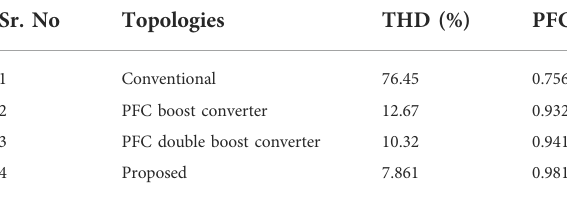
TABLE 2 Analysis of PF and